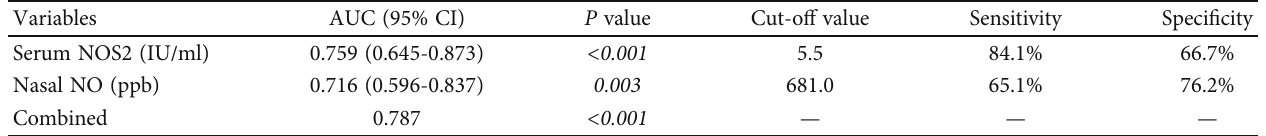
Figure 4: Receiver operating characteristic (ROC) curves for serum NOS2, nNO, and combined serum NOS2 and nNO distinguish responder from nonresponder in AR with SCIT. NOS2: inducible nitric oxide synthase; nNO: nasal nitric oxide; SCIT: subcutaneous immunotherapy. Table 5: ROC results of di ff erent parameters for early predicting SCIT e ffi